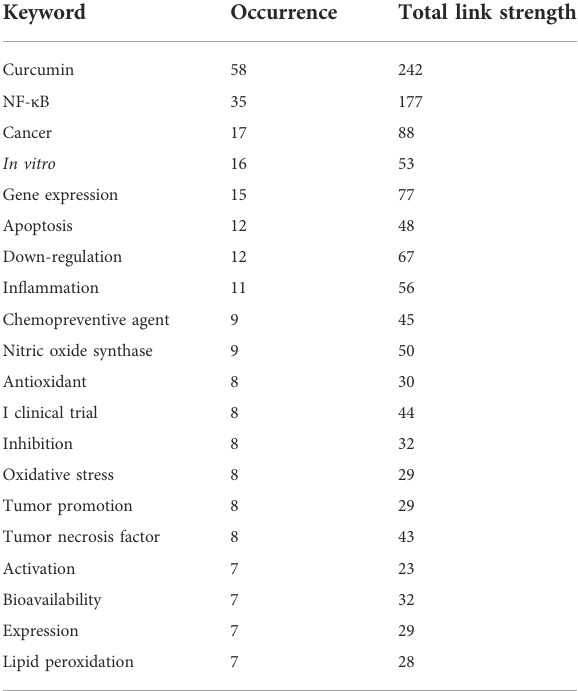
TABLE 5 Top 20 keywords with most frequent